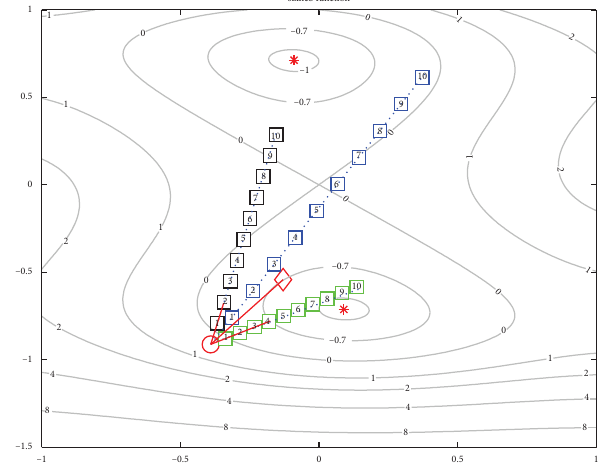
Figure 2: Case a comparison is done between equation (12) and equation